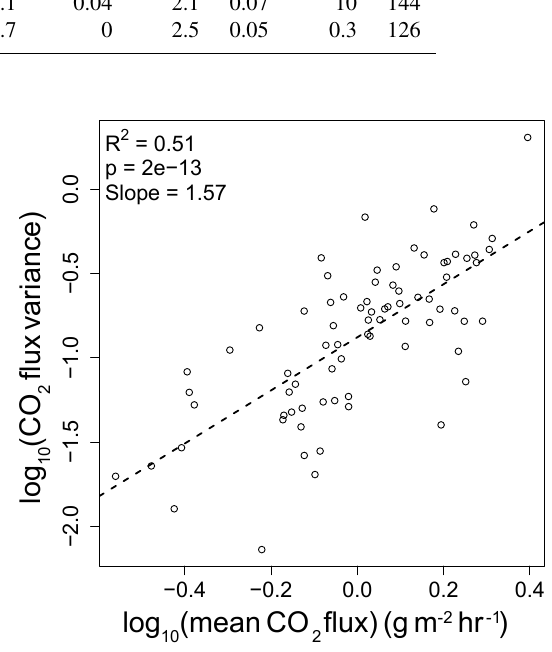
Figure 3. Mean-variance scaling of soil respiration. Each data point is derived from six soil collars used to estimate the variance and mean of soil respiration (see Methods section). The dashed line is the linear regression and statistics are provided, including the slope of the line and p value for model